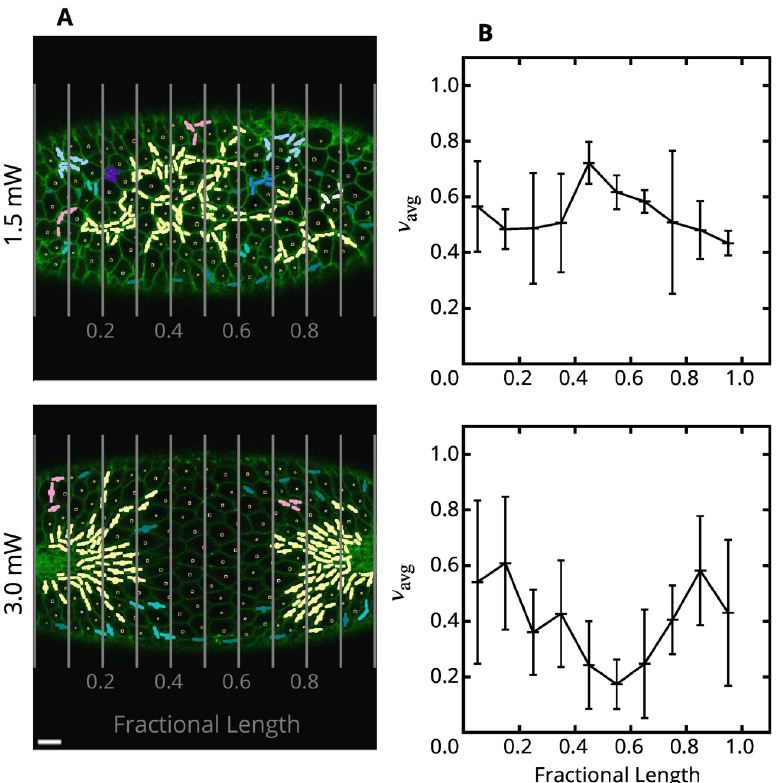
Fig 14. Fractions of constricted cells in optogenetically disrupted embryos. ( A ) Representative images of embryos with a band of cells about their length center optogenetically activated with 1.5 mW (top) and 3.0 mW (bottom) laser (raw data from Guglielmi et al . [25]). Cells are considered constricted if their minor axis length is 1.3 μ m or less. The colors represent the number of cells belonging to a single constricted-cell cluster according to the scale defined in Fig 2. ( B ) Averaged binned fraction of constricted cells, ν avg (normalized by the total number of cells in the analyzed frames), vs fractional position along the observed portion of the mesoderm primordium, as defined by the vertical lines in the corresponding images shown in (A). Due to strong photoactivation the analyzed embryos did not undergo the transition to the fast constriction phase and failed to invaginate; the images were taken at a time after invagination would normally occur. Photoactivation by a 1.5 mW laser beam does not show a constriction deficit in the affected region, indicating a recovery of contractile activity consistent with our predictions. Photoactivation by 3.0 mW shows a significant deficit of constrictions in the affected zone, but the contractile activity does not drop to zero because fragmented constriction chains tend to wrap around the disrupted region. Scale bar: 10 μ m. Embryos ( n = 3) for each experiment. Error bars: